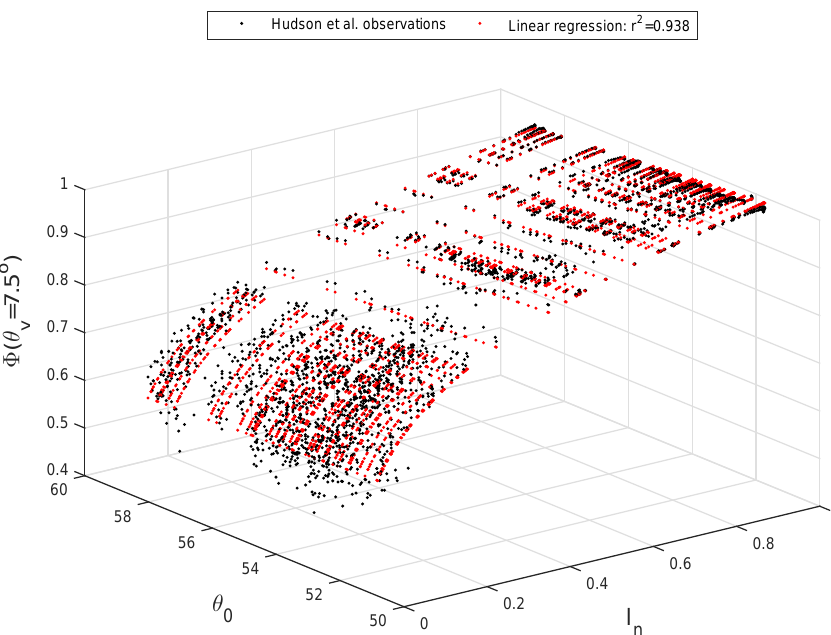
Figure B1. Anisotropic reflectance factor ( (cid:56)) for viewing zenith angle θ v equal to 7.5 ◦ calculated from snow reflectance measurements at Dome Concordia (Antarctic Plateau) by Hudson et al. (2006) vs. solar zenith angle θ 0 and nadir reflectance I n (black dots). The red dots correspond to the multi-linear regression of the logarithm of (cid:56) as a function of the logarithm of spectral albedo and the cosine of θ 0 (see Eq.